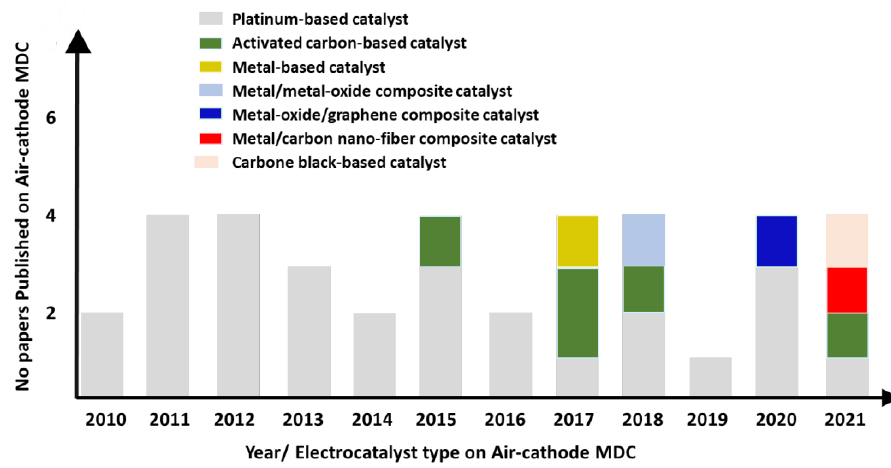
Figure 5. Number of research papers on air cathode MDC (2010 – 2021).